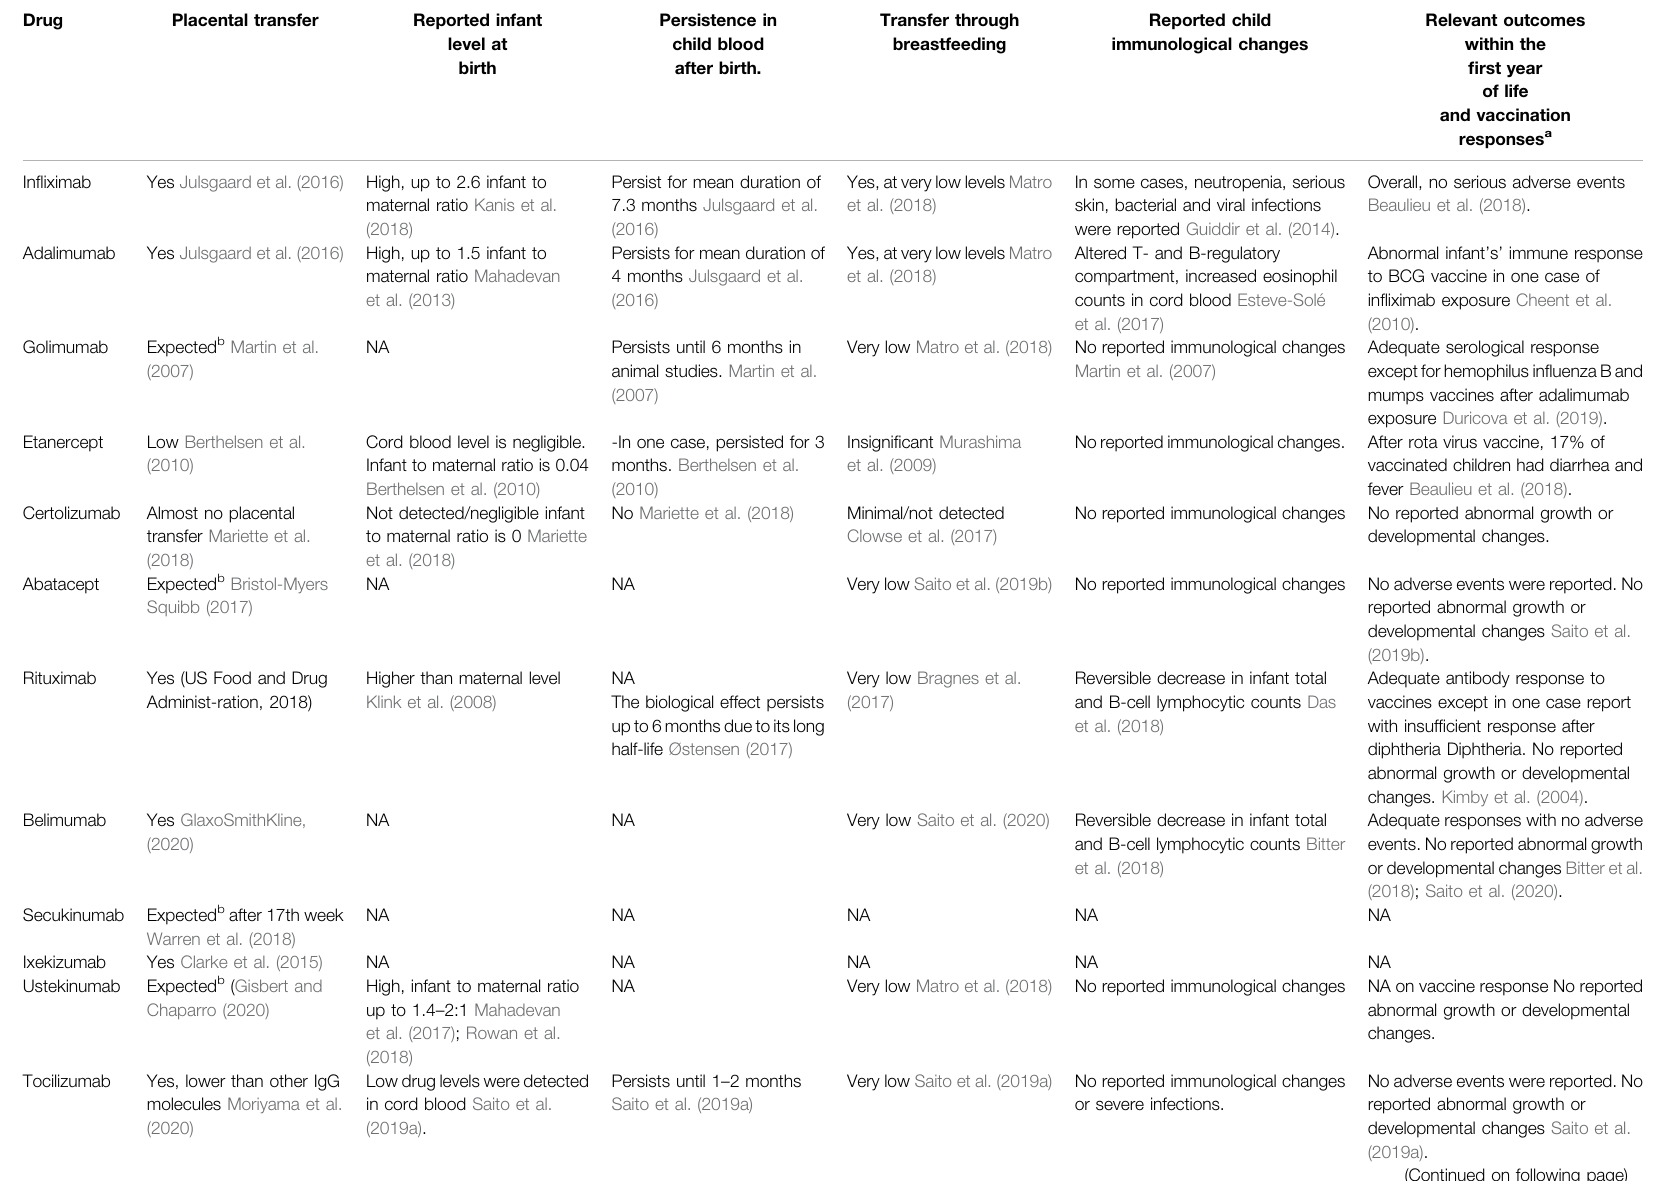
TABLE 4 | Characteristics of transfer of different biologics and their effect on the infants.